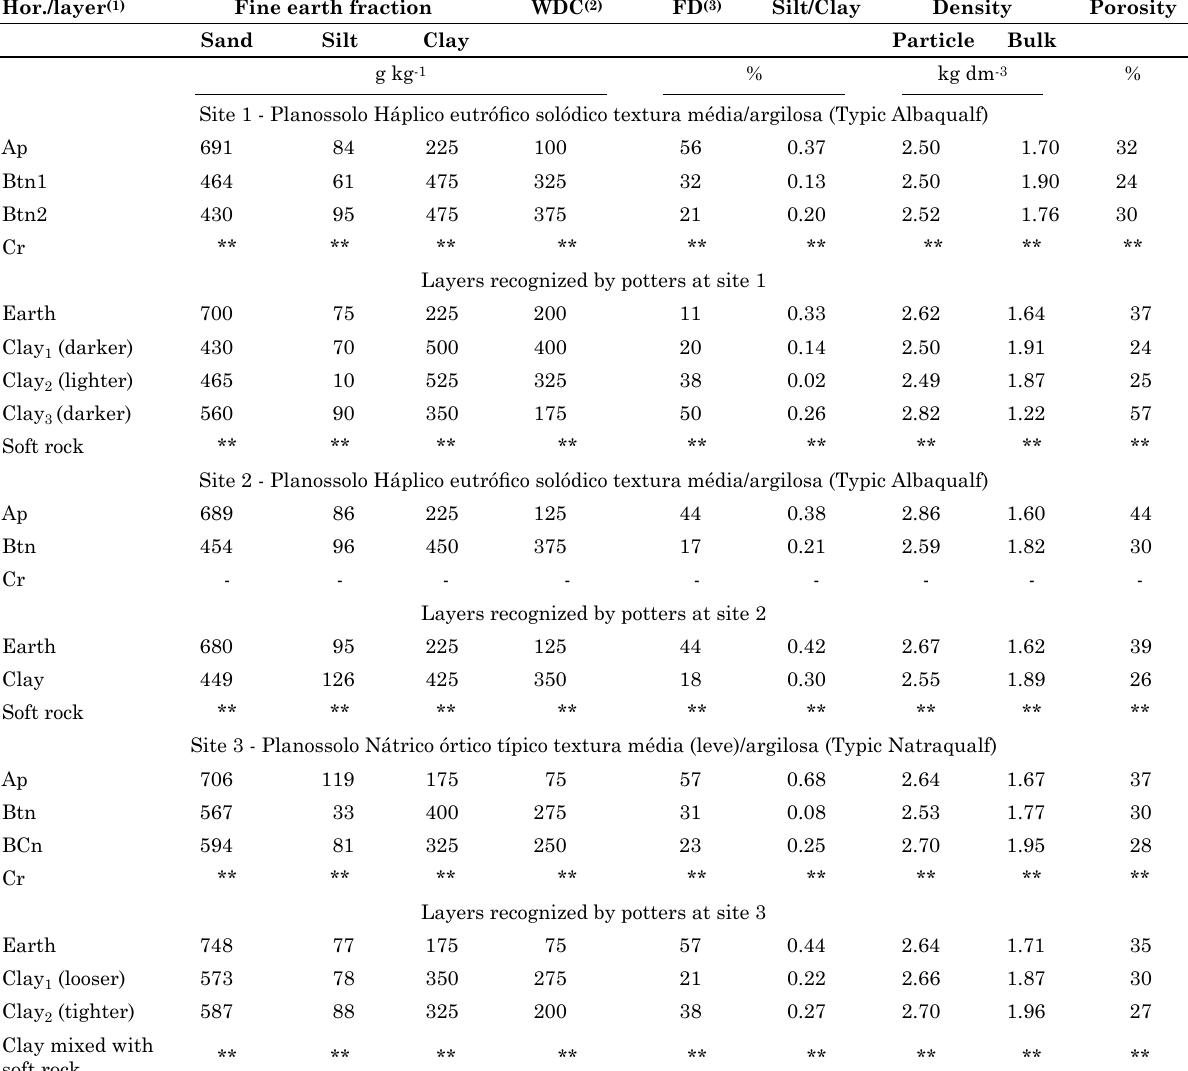
table 2. Physical properties of soils used as a source of “red clay” by peasant potters in altinho, Pernambuco, brazil Hor./layer (1)